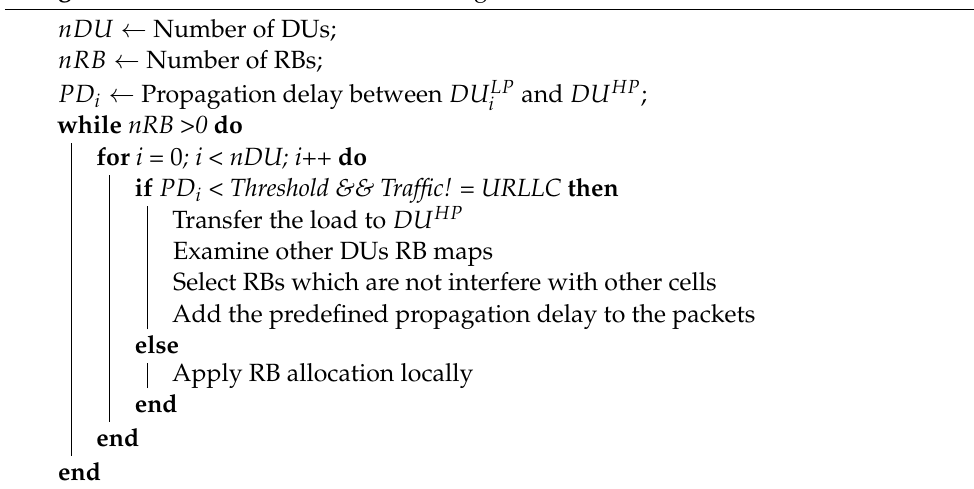
Algorithm 1: Heuristic RB Allocation Algorithm.